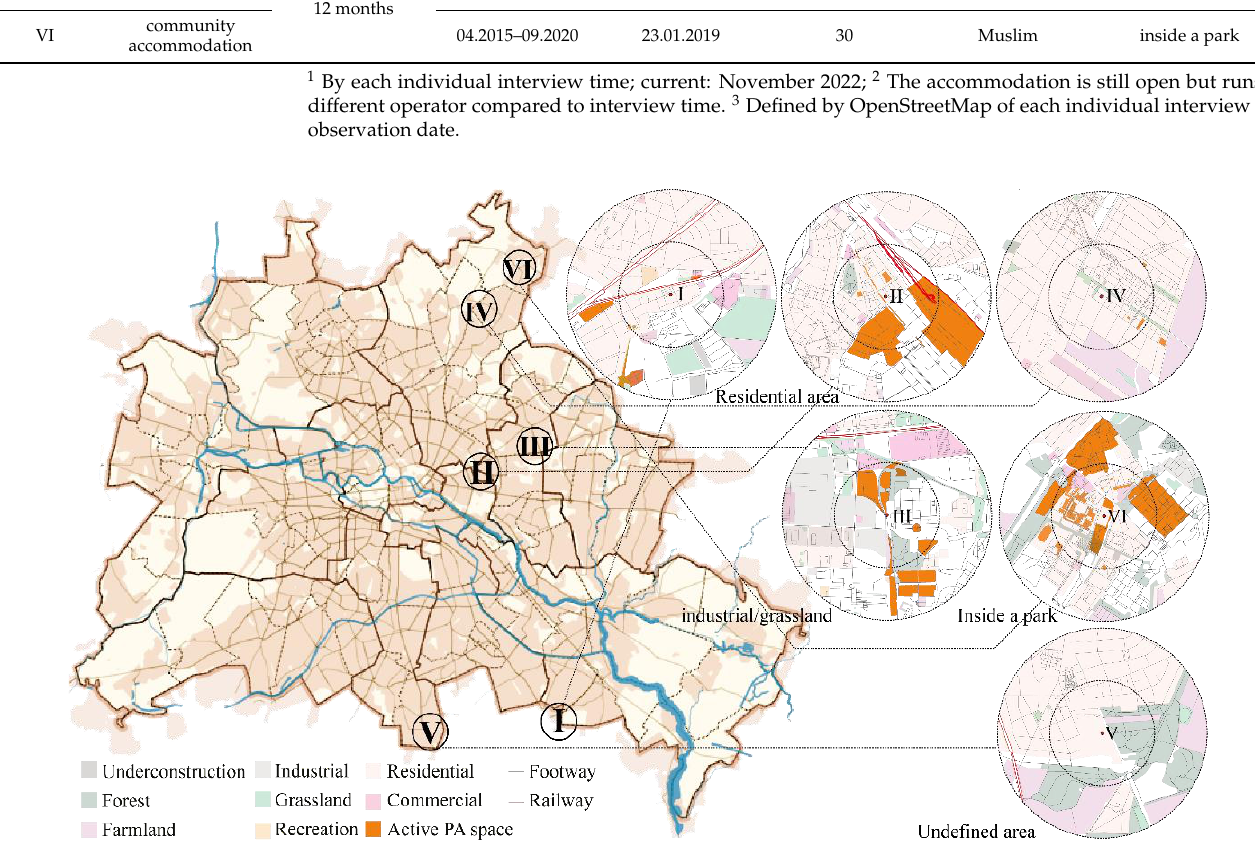
Figure 1. Location (left) and neighbourhood featured in six study sites in Berlin (right). Table 1. Comparison of refugee accommodation fe atures, children’s demographic information and neighbourhood features across six study sites.